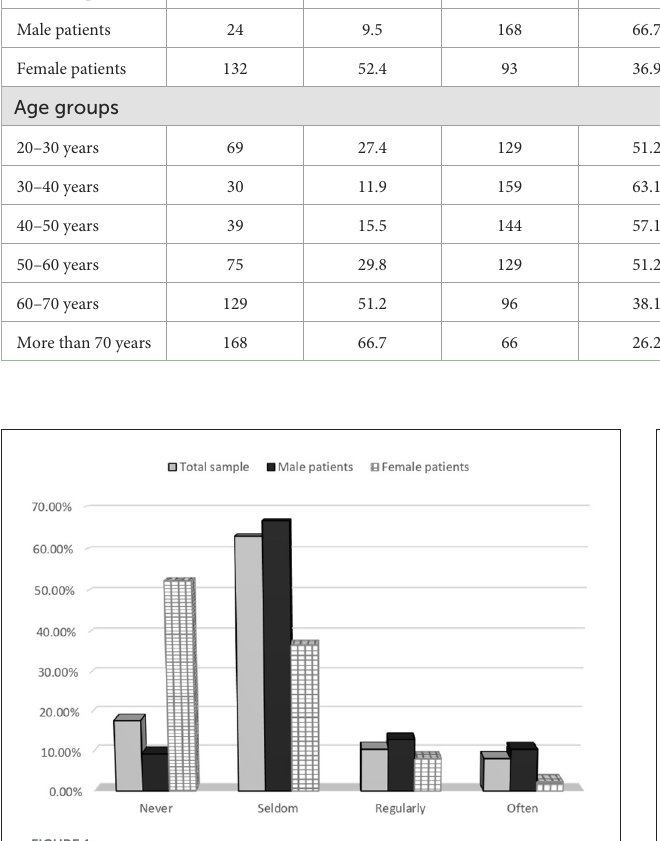
FIGURE1 Discussing sexuality with patients with neurological disease, total results, and results in subgroups according to gender.